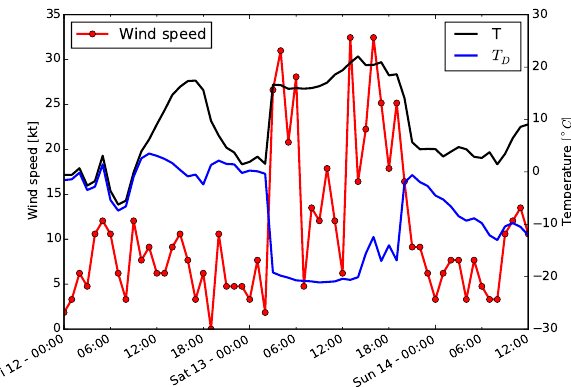
Figure 2. Measurements from an automatic weather station from the National Weather Service of Argentina at Catamarca Airport, 120km from the Fiambalá Basin. Wind speed (red line with circle markers), temperature ( T , black line), and dew point temperature ( T D , blue line). The signatures of a zonda episode, i.e., warm, dry, and windy conditions, are observed on 13 June.